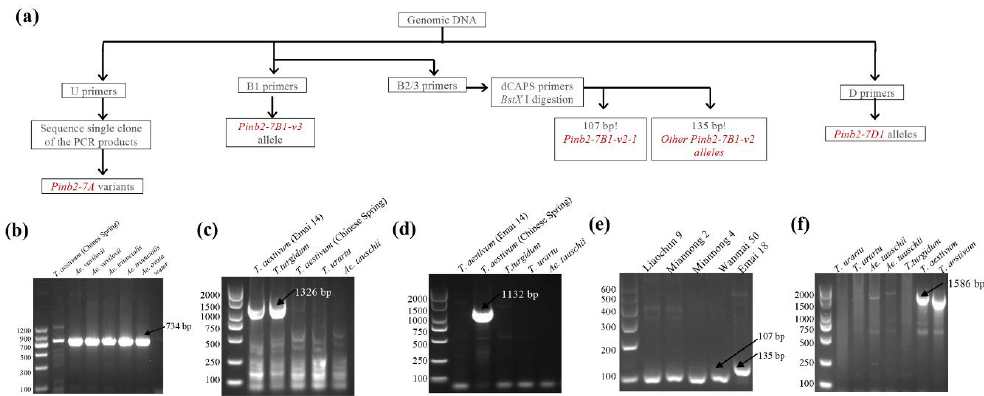
Figure 4. Genotyping of Pinb2 genes using the new PCR method. ( a ) Diagram describing the workflow of set of PCR primers to genotype Pinb2-7A , Pinb2-7B and Pinb2-7D loci. ( b ) Primer pair U non-specifically amplified Pinb2 genes encoded by Pinb2-7A , Pinb2-7B and Pinb2-7D loci from several Triticeae species. Sizes of DNA markers used are labeled. Specific PCR products are pointed out by black arrowheads. ( c ) PCR primer pair B1 specifically detected the Pinb2-7B1-v3 allele in bread and durum wheats ( T. aestivum and T. turgidum spp. durum ). ( d ) Nested PCR primer sets B2/B3 specifically detected the Pinb2-7B1-v2 allele in bread wheat ( T. aestivum ) Chinese Spring. ( e ) The dCAPS primers-derived PCR amplification and subsequent BstX I digestion distinguished the Pinb2-7B1-v2-1 allele (107 bp) from the other Pinb2-7B1-v2 alleles (135 bp). ( f ) PCR primer pair D specifically amplified the Pinb2-7D1 gene in bread wheat.